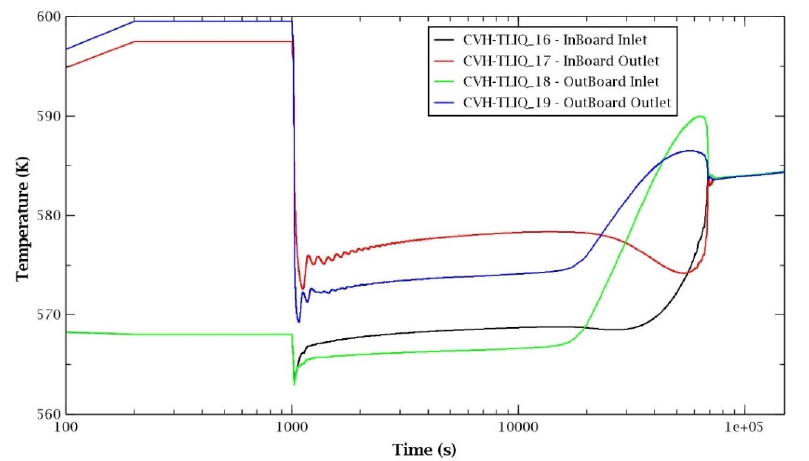
Figure 12. Temperature evolution in the BB: Case 1.